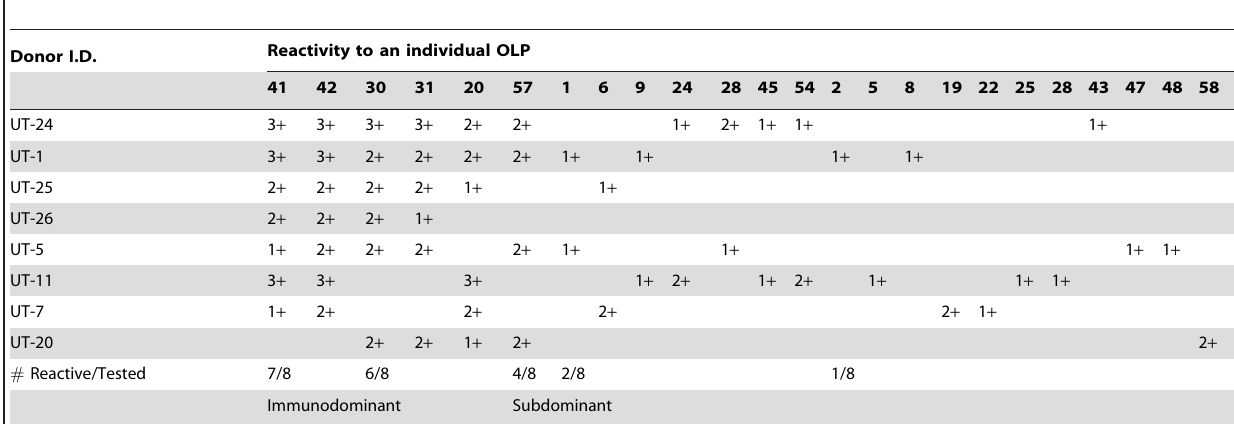
Table 1. Classification of immunodominant and subdominant reactivity to OLPs in eight N-specific CD8 + T cell cultures from different HLA-A*0201 + donors.